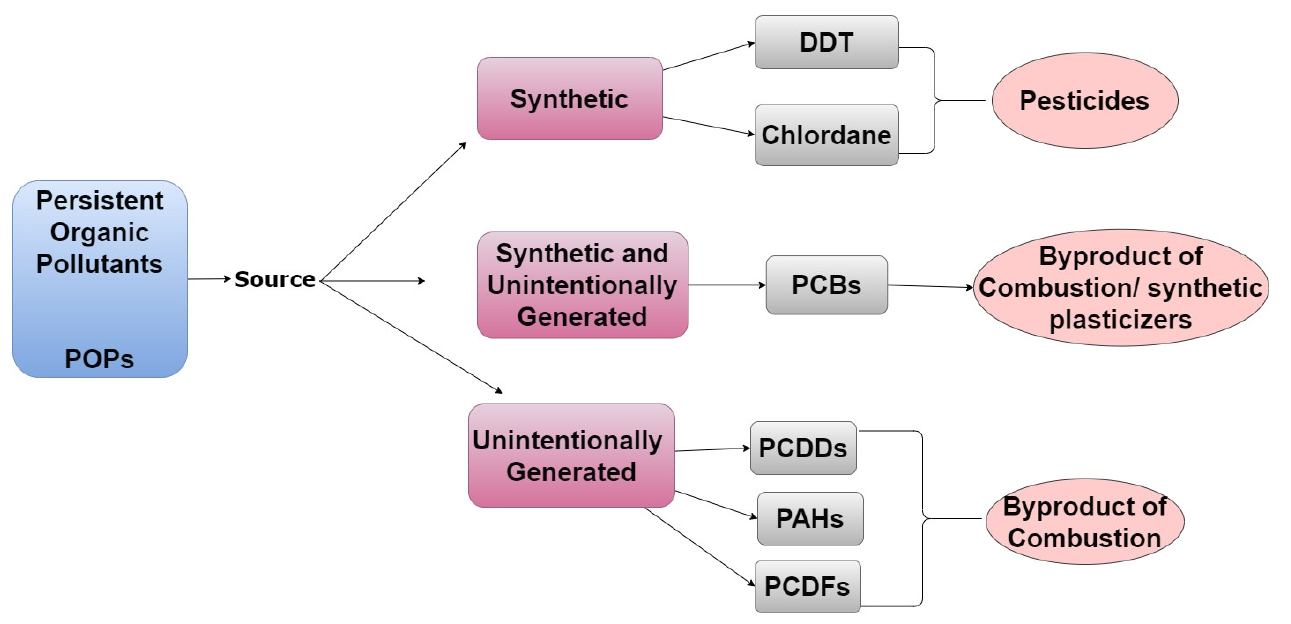
Figure 1. A tree diagram listing emission sources of POPs, representative examples of chemicals from each source, and how/why they are in the environment.